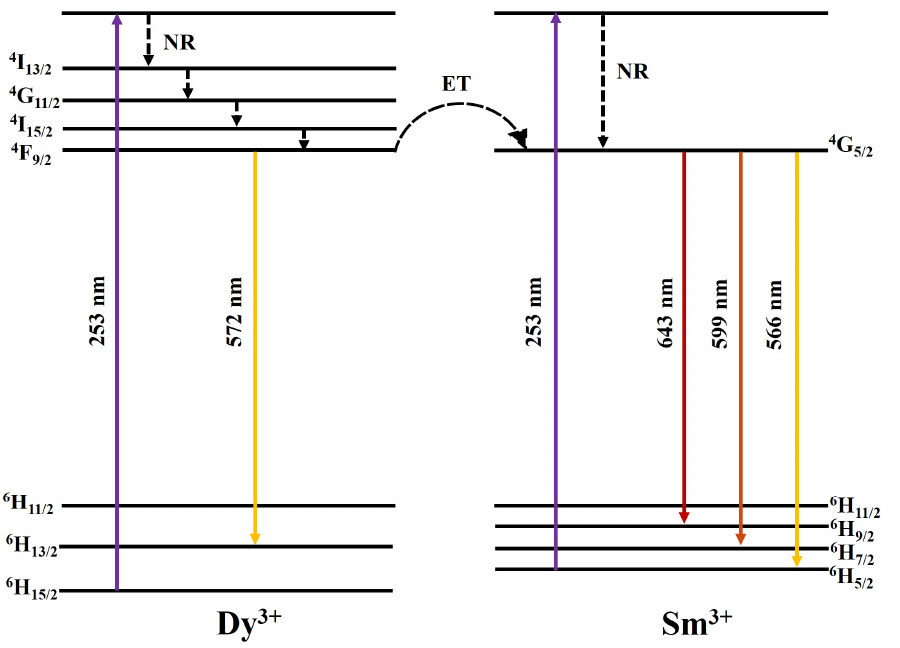
Figure 8. Schematic of energy level structure of the Dy 3+ and Sm 3+ ions.